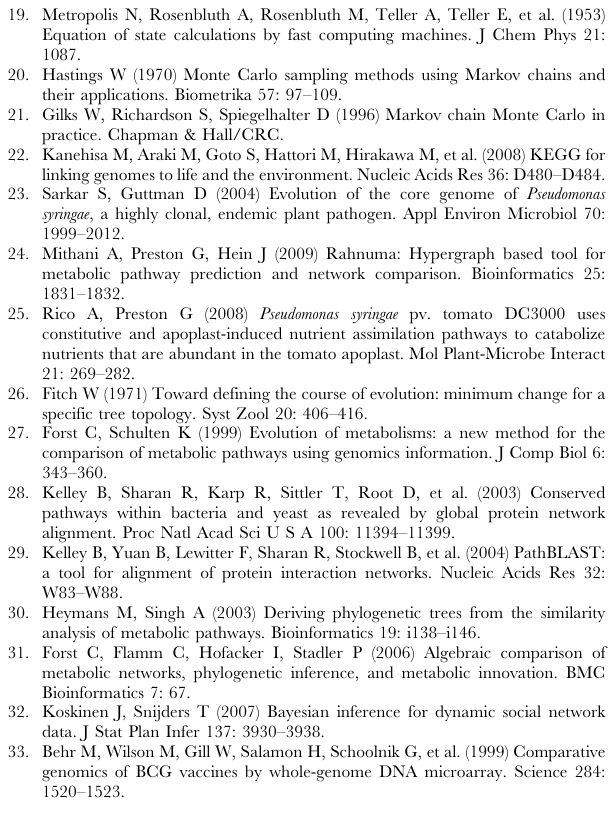
every 10 th iteration. Strain abbreviations: pfl: Pseudomonas fluorescens Pf-5, pfo: Pseudomonas fluorescens Pf0-1, pfs: Pseudomonas fluorescens SBW25, psb: Pseudomonas syringae pv. syringae B728a, psp: Pseudomonas syringae pv. phaseolicola 1448A, and pst: Pseudomonas syringae pv. tomato DC3000. Table S4 Running time and the acceptance percentage of the Gibbs sampler for the estimation of evolution parameters ( d : neighbor dependence probability, l : insertion rate and m : deletion rate) run under the hybrid model for different metabolic networks over the phylogeny connecting different Pseudomonas strains (Figure 6). Hyperedges that were common to all seventeen strains were regarded as core edges and hyperedges missing in all seventeen strains were regarded as prohibited edges. The values are averaged across three runs of 60,000 iterations for P. fluorescens and P. syringae phylogenies, and 110,000 iterations for